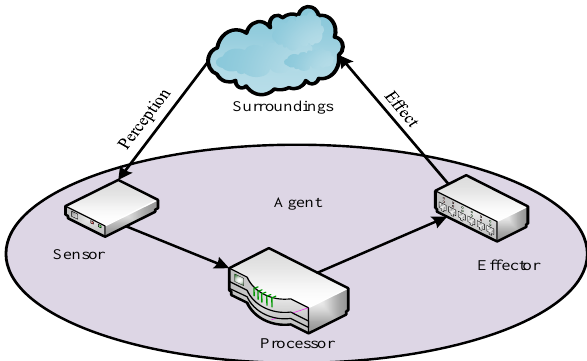
Figure 1. Basic structure of a single agent.